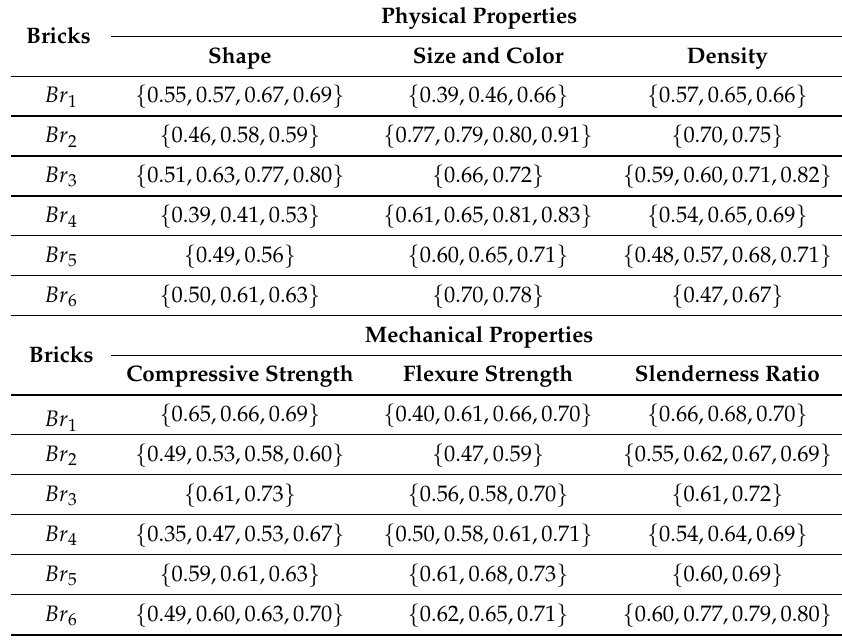
Table 2. Tabular representation of 3HF decision